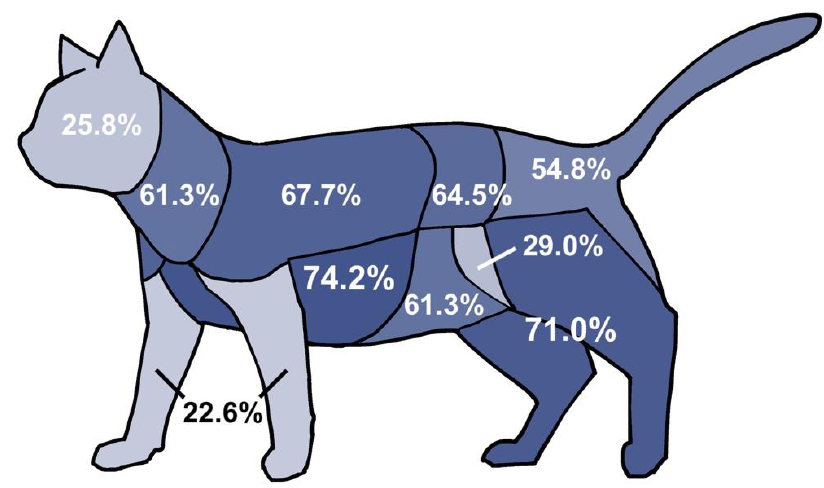
Figure 1. Illustration of the distribution of soft tissue injuries in different body regions of cats.